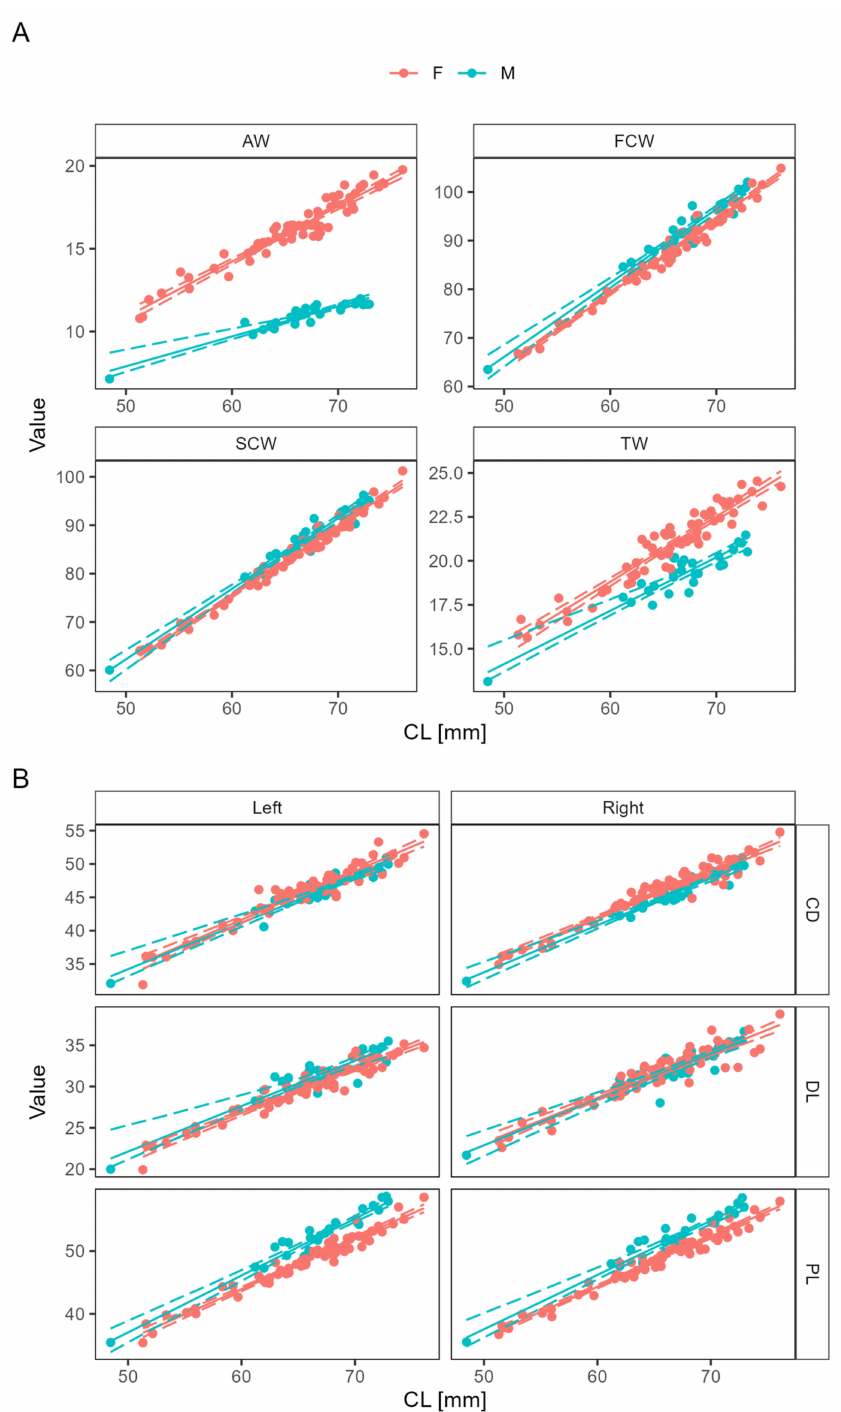
Figure 2. Linear regression models with 95% confidence intervals between different morphometric characters and carapace length of Calappa granulata males (M) and females (F) collected from the central eastern Adriatic Sea: ( A ) no left/right sided characters; ( B ) left/right sided